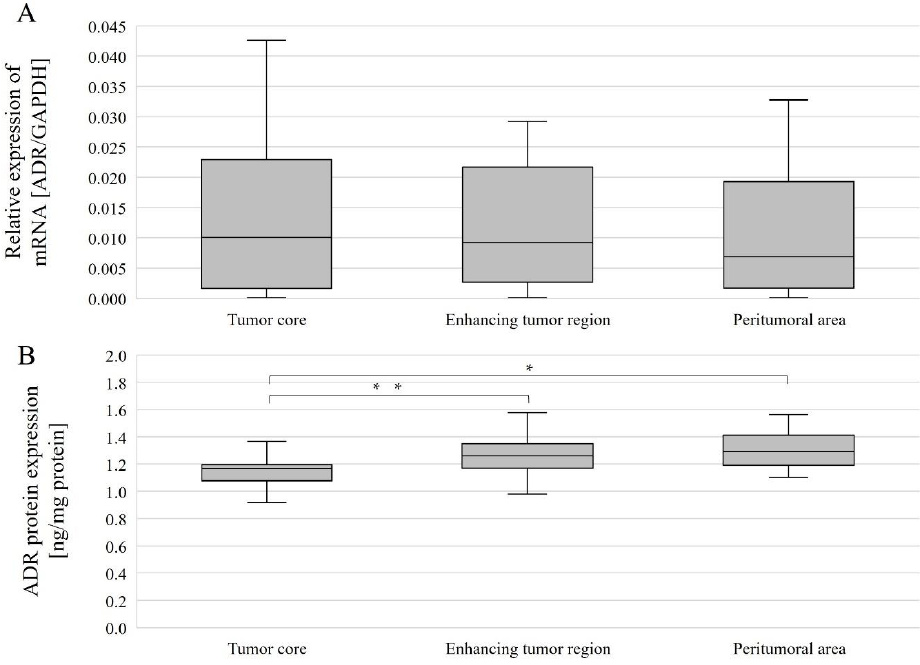
Figure 7. AR gene ( A ) and AR protein ( B ) expression in individual GBM structures obtained from patients. Data are representative of individual structures (tumor core, enhancing tumor region, and peritumoral area) in all patients. Statistical analysis was performed using Wilcoxon signed-rank test, * p < 0.05, ** p < 0.01.